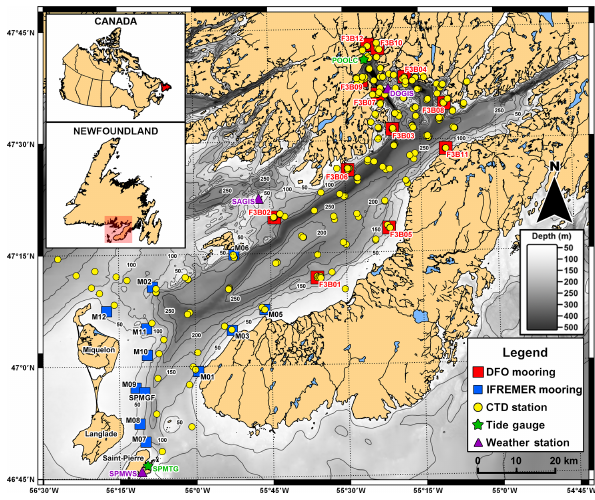
Figure 1. Study area and summary of the observation